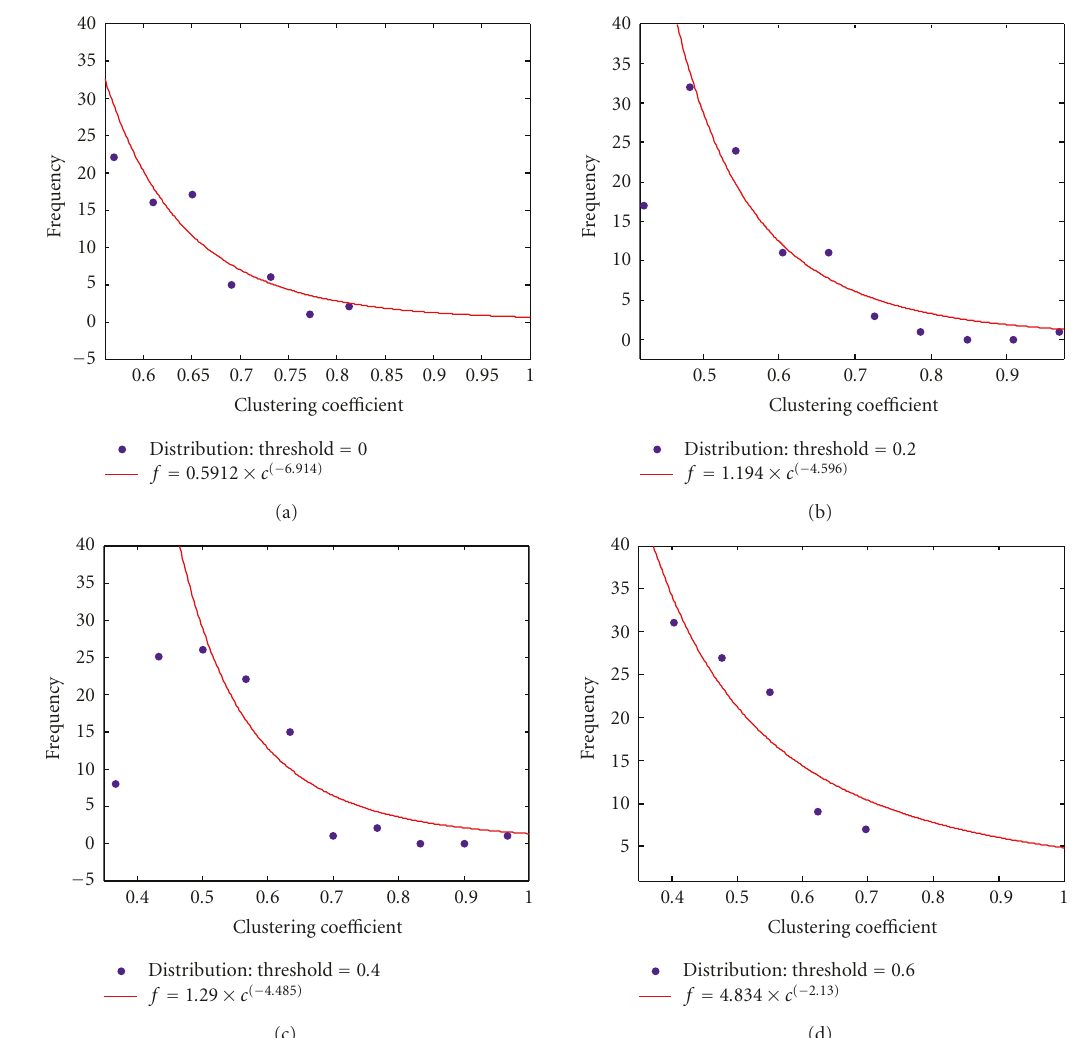
Figure 9: Power law for distribution of clustering coe ffi cient (MATLAB): dataset